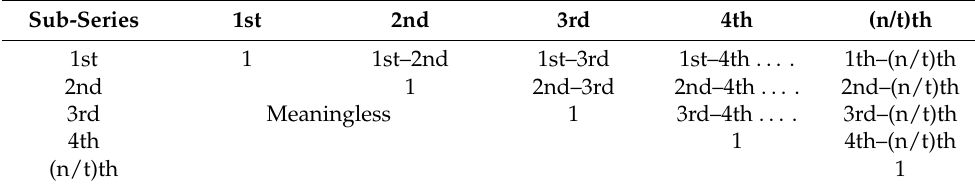
Figure 1. Flowchart proposed for the analysis combining innovative triangular trend analysis (ITTA) with discrete wavelet transform (DWT) (ITTA–DWT: hybrid method). Table 1. Theoretical ITTA comparison set proposed by